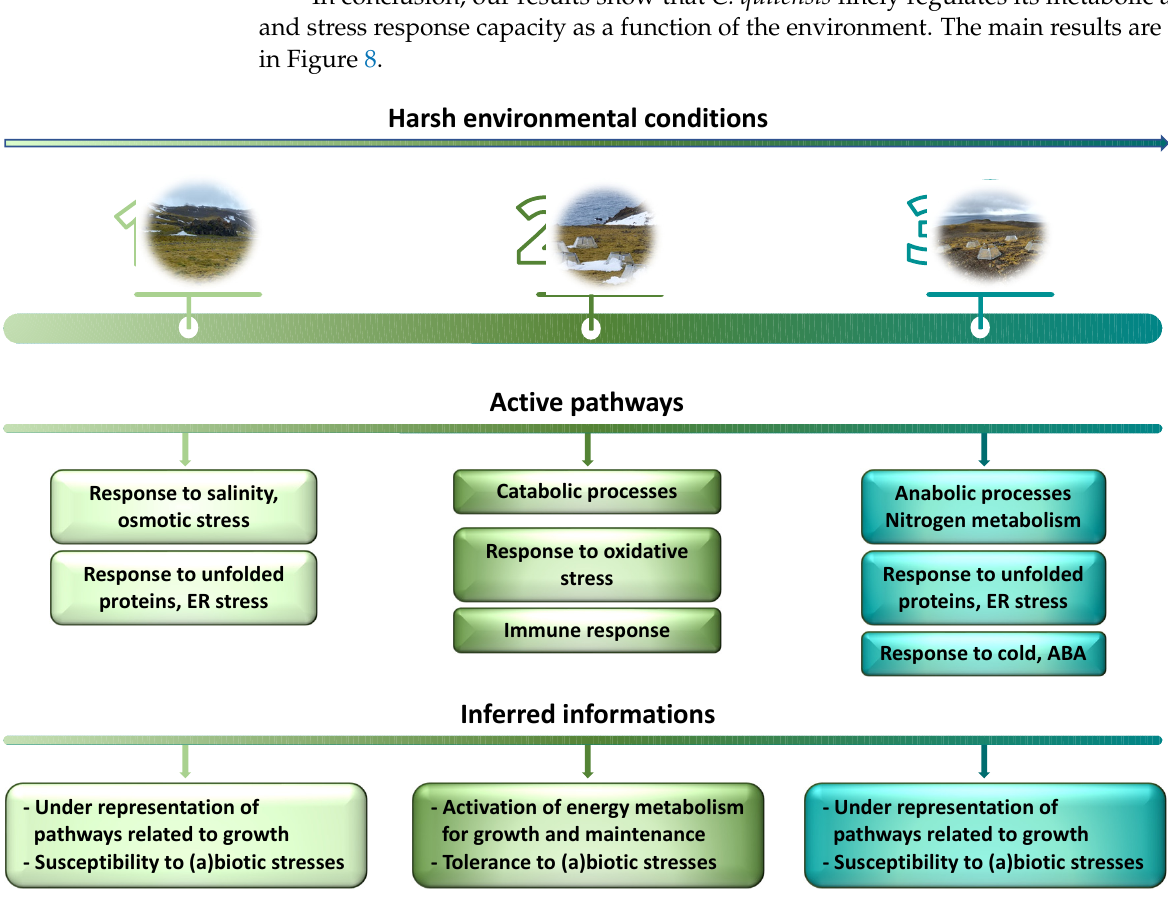
Figure 8. Outline of the main results obtained in the present paper.